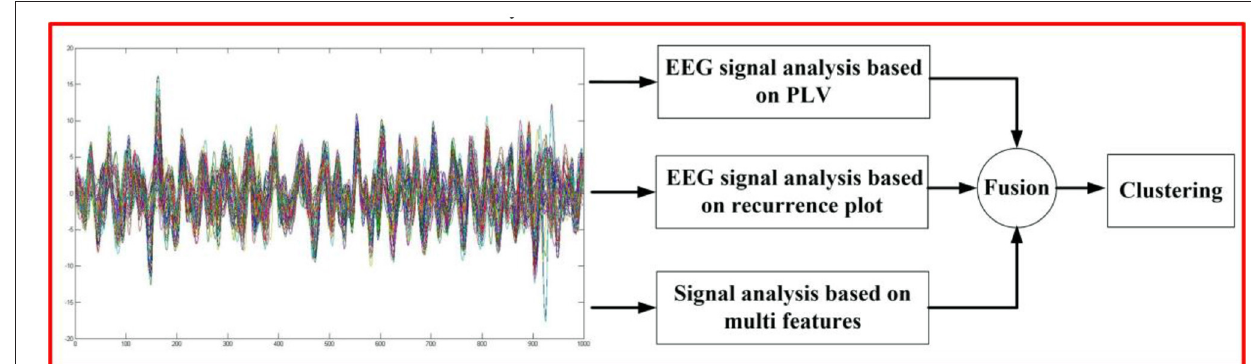
FIGURE 1 | The proposed algorithm flow chart.